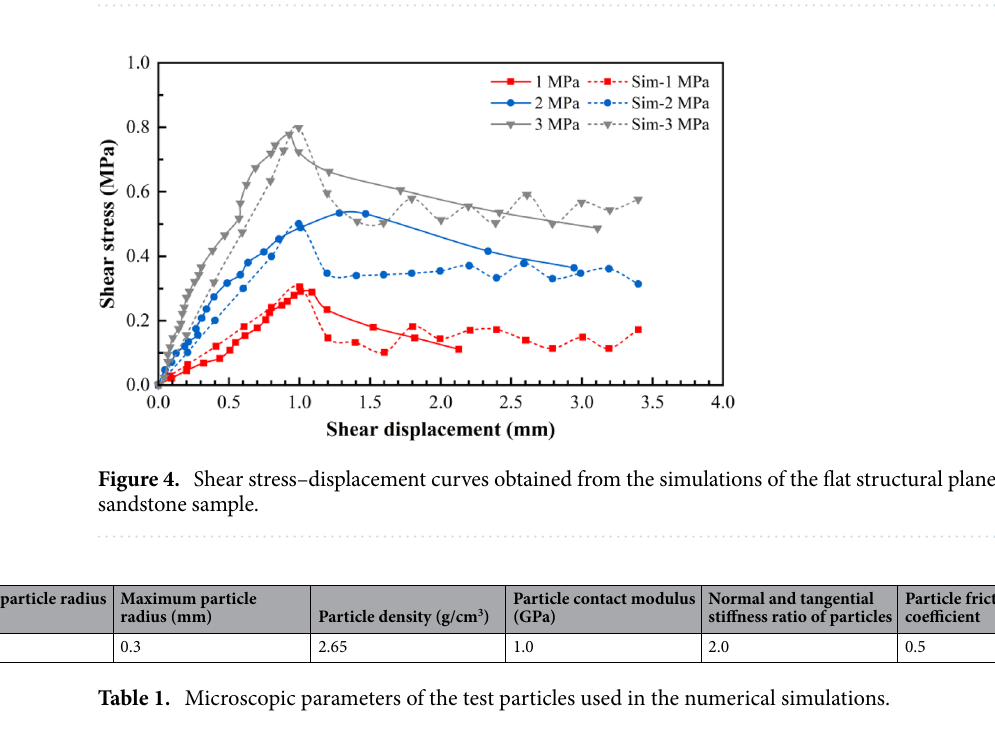
Figure 3. Comparison of the shear stress–displacement curves obtained from the physical direct shear tests and simulations on the sandstone sample without a structural plane.